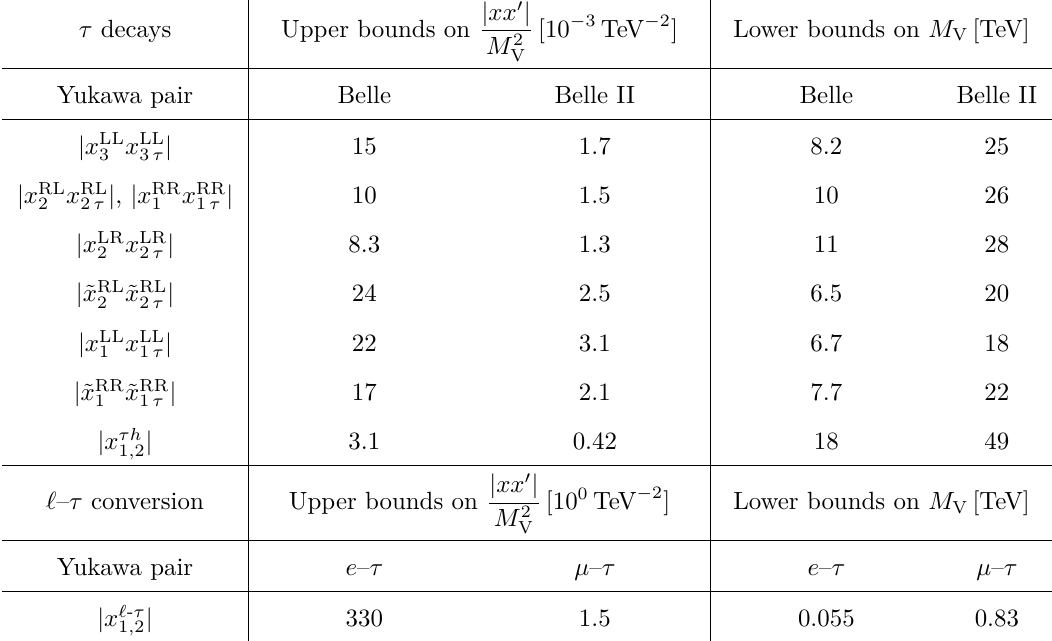
; these numbers also V = 1 TeV. On the right, there V